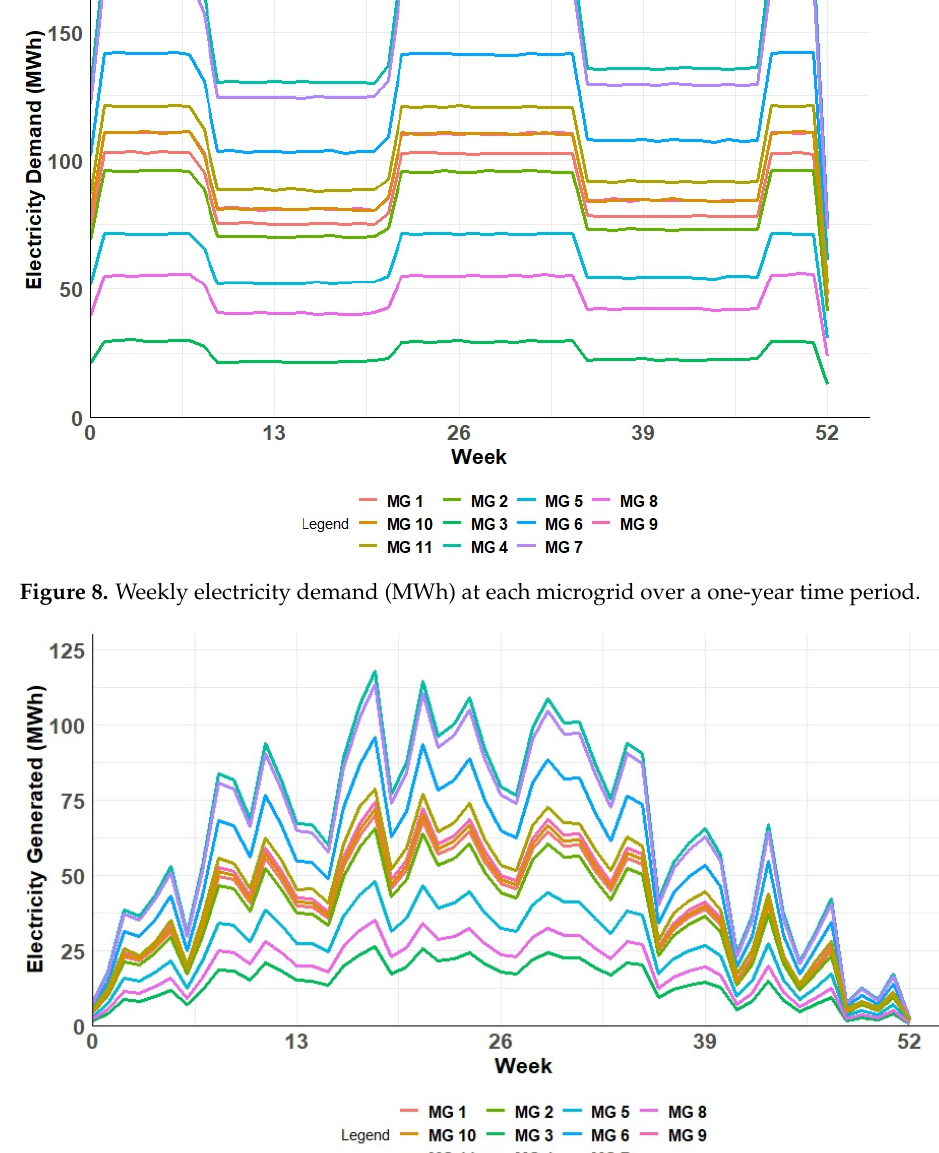
Figure 8. Weekly electricity demand (MWh) at each microgrid over a one-year time period.